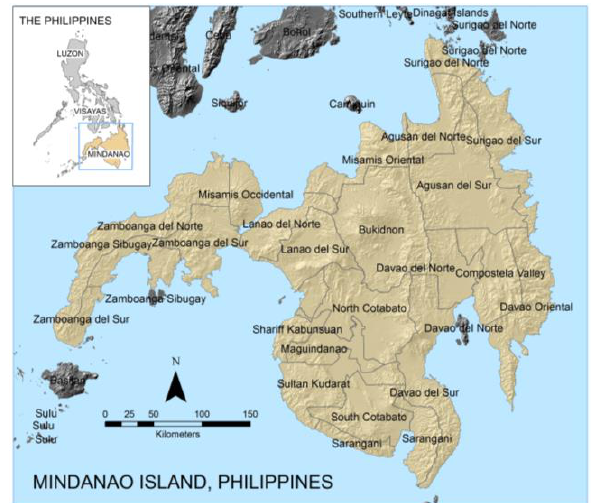
Figure 1. Map showing the location of Mindanao Island, Philippines and the provinces